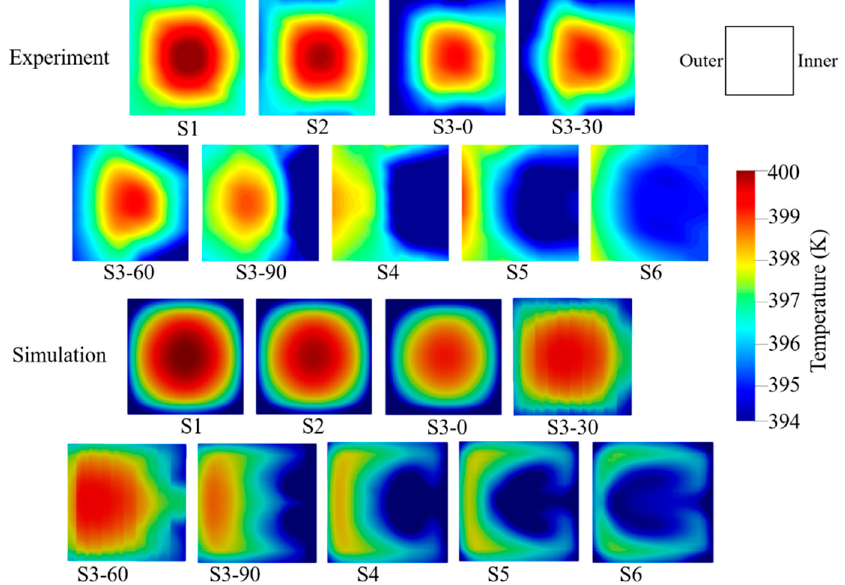
Figure 10. Temperature contour comparison between experiment and simulation in streamwise direction of curved pipe.